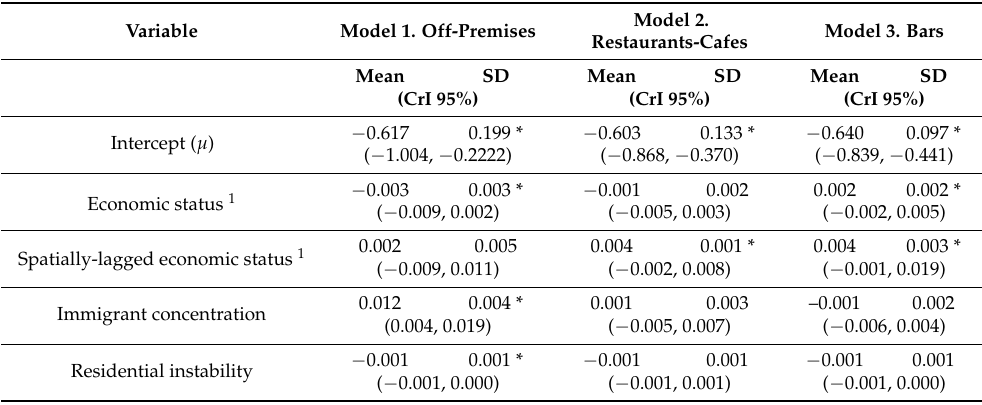
Table 4. Spatiotemporal Bayesian model estimates of alcohol outlets